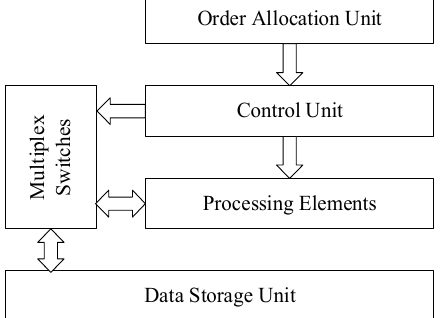
Figure 2. The structure of a microprocessor core.